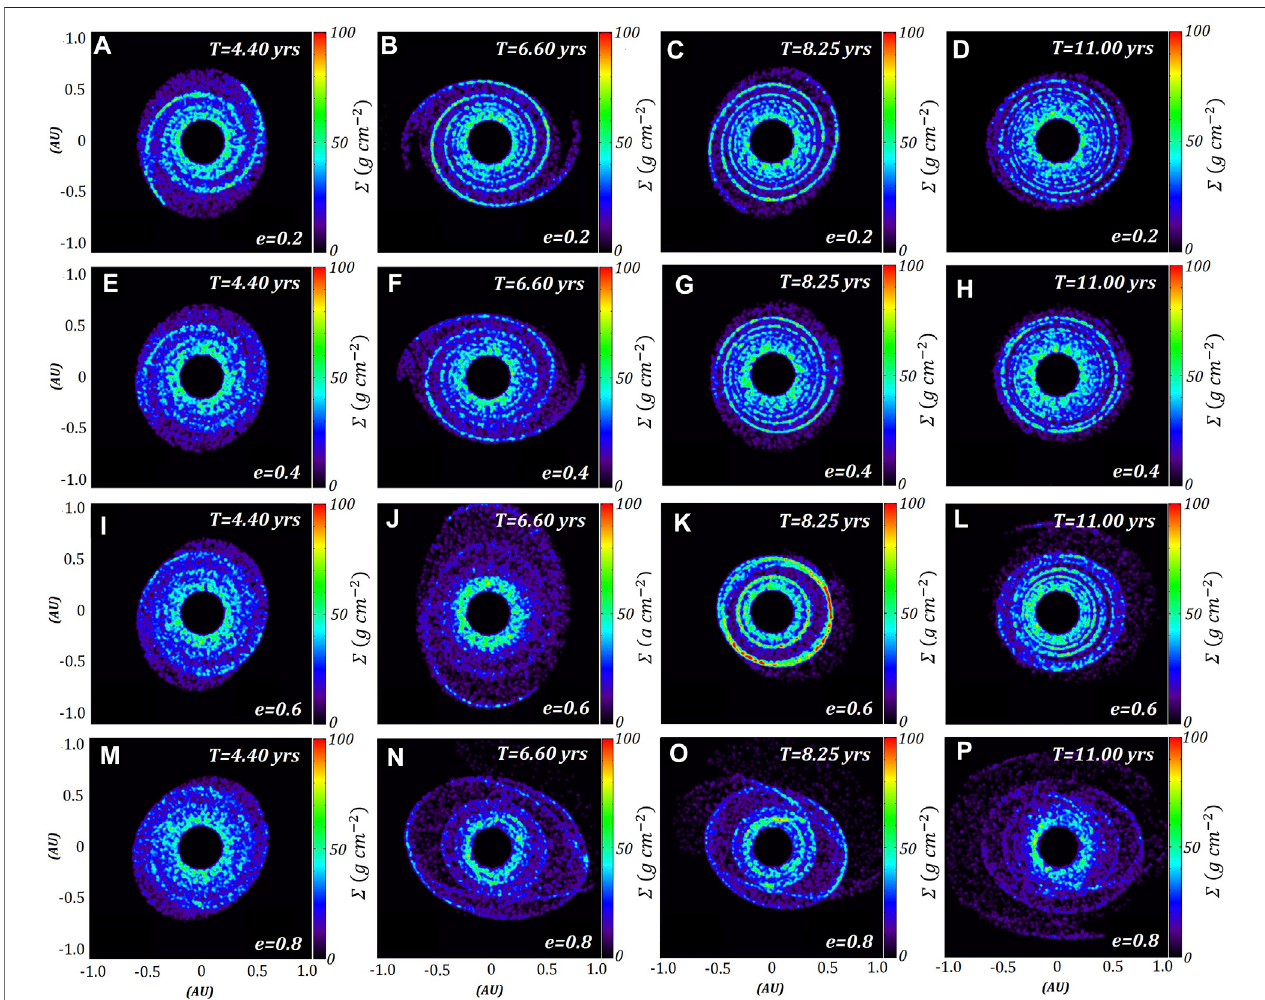
FIGURE 4| Surfacedensities ofthe samefour models as Figure 3 . The x and y axes represent the instanteous positions of ring particles around J1407b, which is at the origin. The rows represent each model, where e (cid:1) 0 . 2 (A – D) , e (cid:1) 0 . 4 (E – H) , e (cid:1) 0 . 6 ( i − l ) and e (cid:1) 0 . 8 ( m − p ) , while the column represents a snapshot in time at T (cid:1) 4 . 40 yrs ( A , E , I & M ) , T (cid:1) 6 . 60 yrs ( B , F , J & N ) , T (cid:1) 8 . 25 yrs ( C , G , K & O ) , T (cid:1) 11 . 00 yrs ( D , H , L & P ) , where all models began at